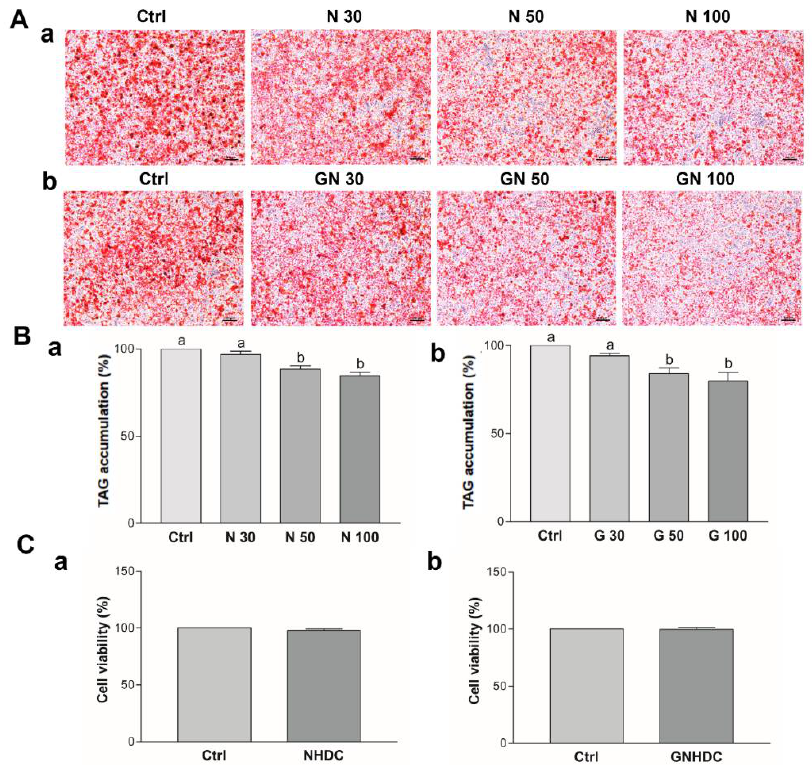
Figure 4. Effects of ( a ) NHDC and ( b ) GNHDC on lipid accumulation and cell viability in 3T3-L1 cells. Lipid accumulation was measured by ( A ) oil red O staining (magnification 100×, scale bar 100 μm) and ( B ) Triacylglycerol accumulation was quantified with Ctrl, 30 μM, 50 μM, and 100 μM ( a ) NHDC or ( b ) GNHDC. ( C ) Cell viability in 3T3-L1 cells was evaluated with 50 μM ( a ) NHDC or ( b ) GNHDC.